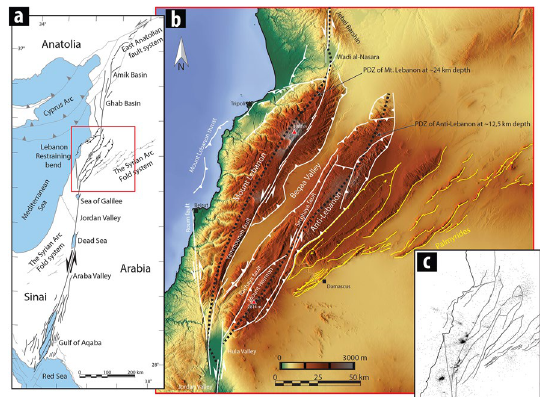
Figure 1. Structural map of Lebanon Restraining bend. ( a ) Different tectonic structural styles along the Dead Sea Transform: (1) Inactive distributed shear along the onshore margins of the Gulf of Aqaba, and southward increasing transtension forming the gulf; (2) pure strike-slip deformation in the Araba and Jordan valleys; with three step-over basins in the Dead Sea, Sea of Galilee and Hula Valley; (3) a restraining bend and transpressional structures along the LRB; and (4) transtensional structures within the Ghab and Amik basins. ( b ) 90 m DEM of the studied area (red square in a ). The white lines are the main faults of the LRB. The yellow lines are thrust faults along the Palmyride fold belt. Map obtained from maps-for-free.com. ( c ) Seismicity between 2006 and 2018 as recorded by GRAL. Data provided by CNRS Lebanon—National Center for Geophysical